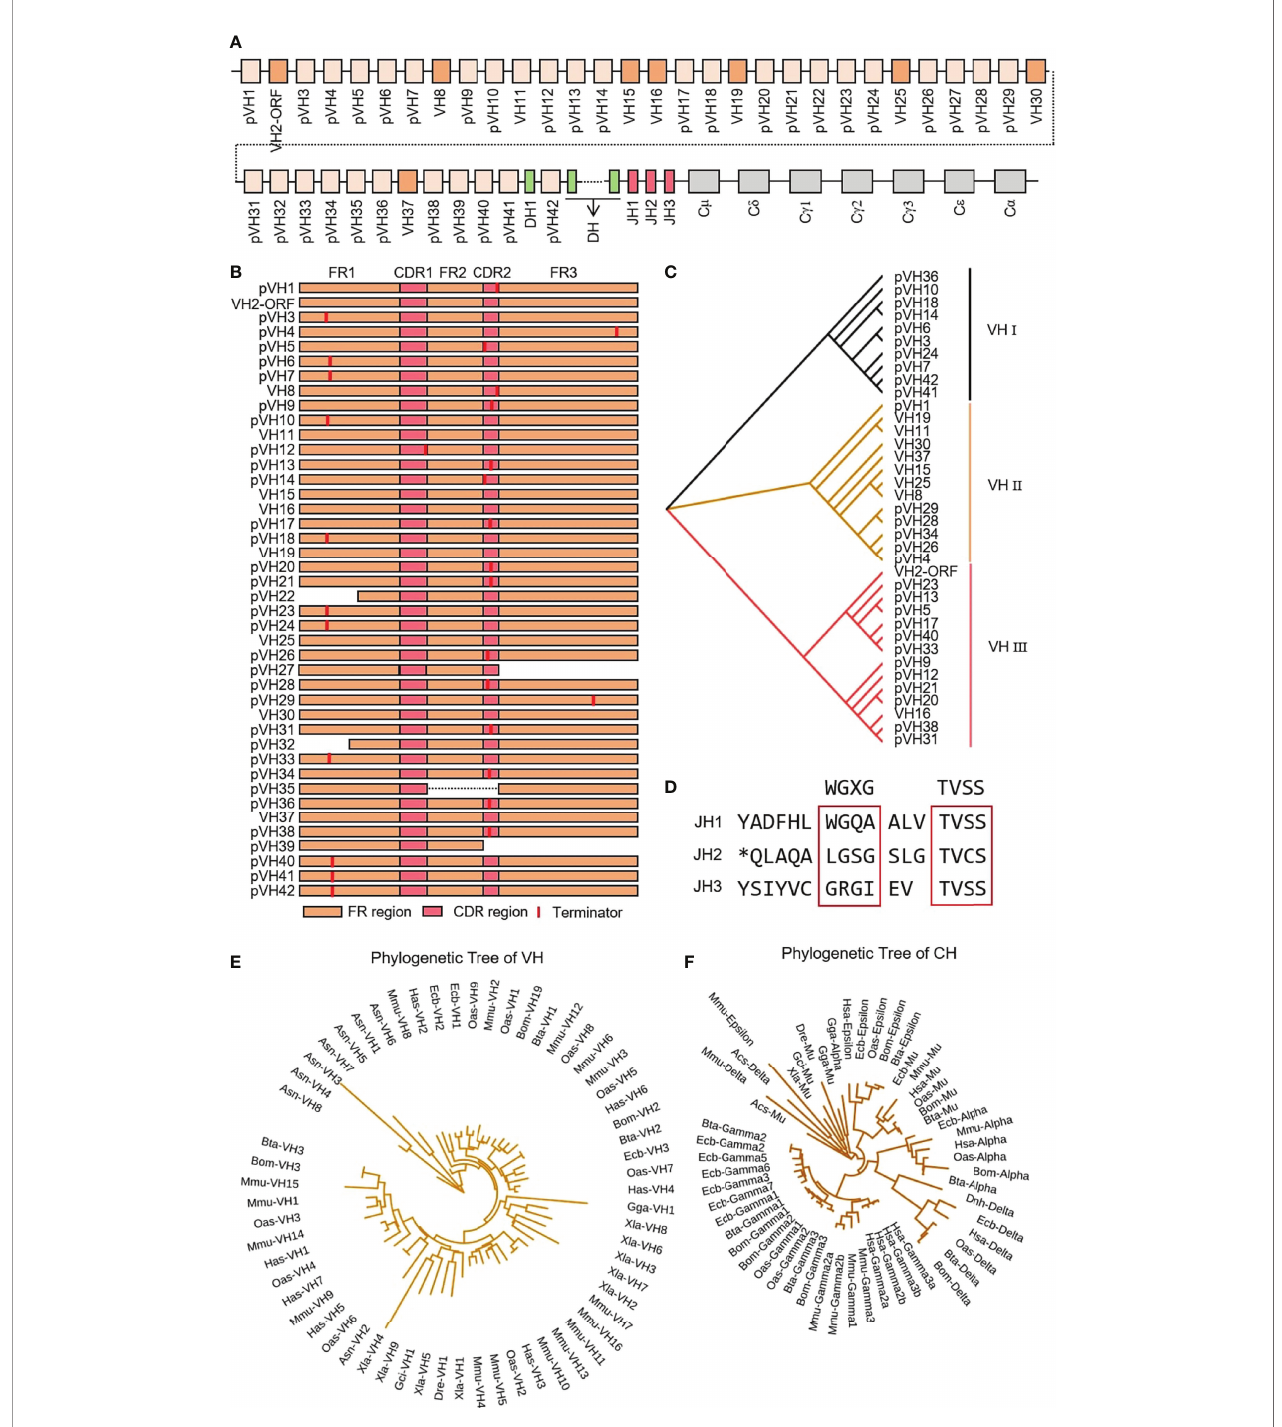
FIGURE 1 | Schematic structure of the genomic organization of Yak IgH and its relatedness with representative vertebrate species. (A) Schematic structure of the genomic organization of Yak IgH; (B) The structural variation of Yak VH; (C) The phylogenetic tree of yak VH; (D) The structural variation of Yak JH, *: termination codon (E) The phylogenetic tree of VH in yak and representative vertebrate species; (F) The phylogenetic tree of different CH gene family between yak and representative vertebrate